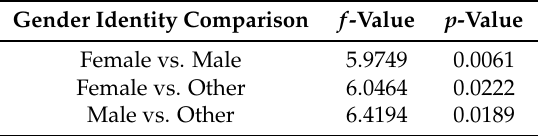
Table 5. Calculated ANOVA score for top words used among gender identities to define visual privacy.